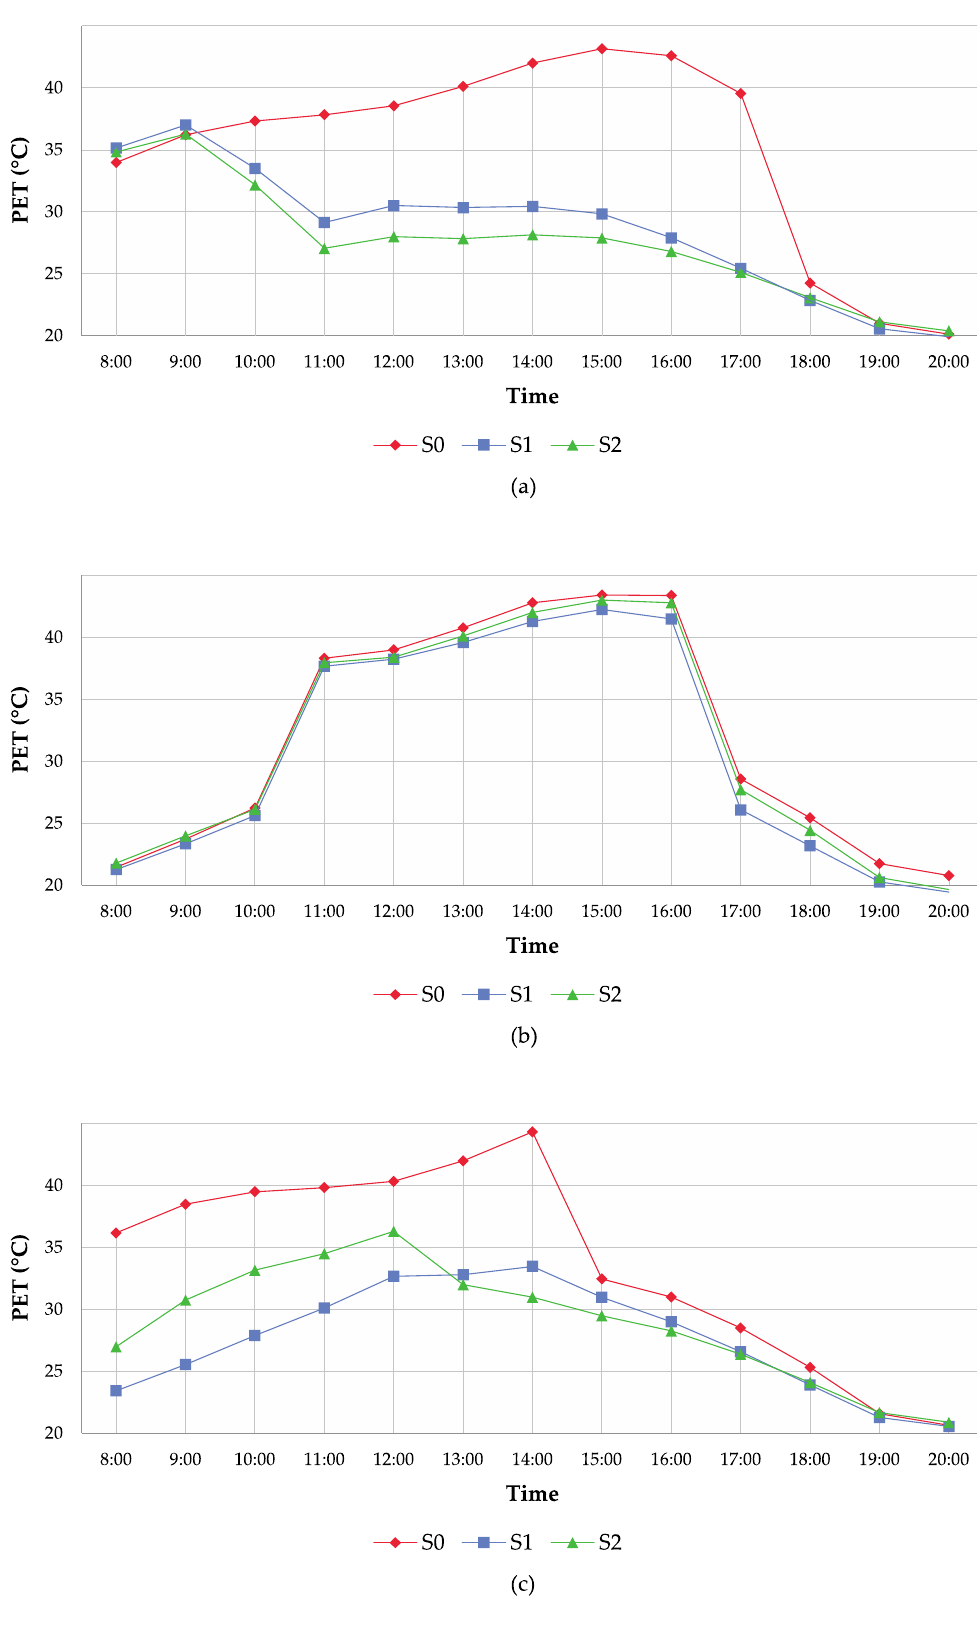
Figure 7. ( a ) Daily trend , on 1 st August 2014, of PET values in point A among the three scenarios: S0 (initial condition), S1 (cool pavements + trees) and S2 (cool roofs + cool walls + trees + grass) ; ( b ) daily trend of PET values in point B among the three scenarios: S0, S1, S2; ( c ) daily trend of PET values in point C among the three scenarios: S0, S1, S2.